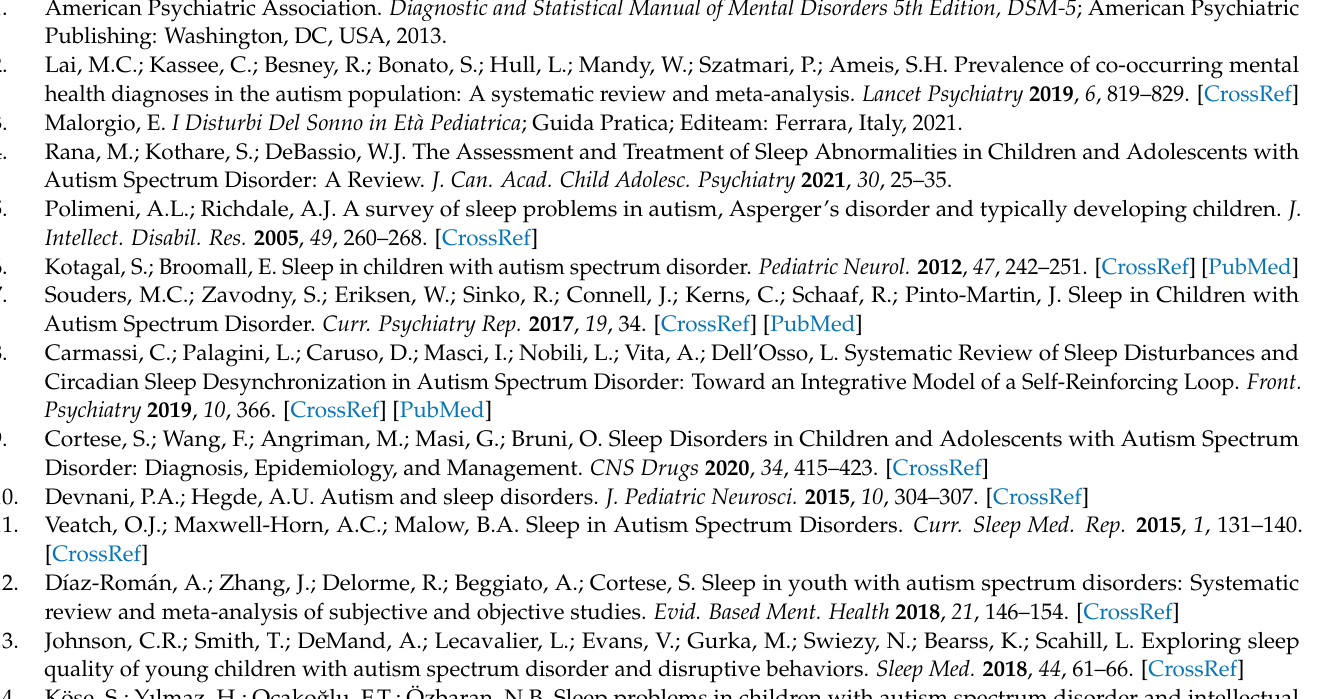
TD, Table S4: Summary comparison